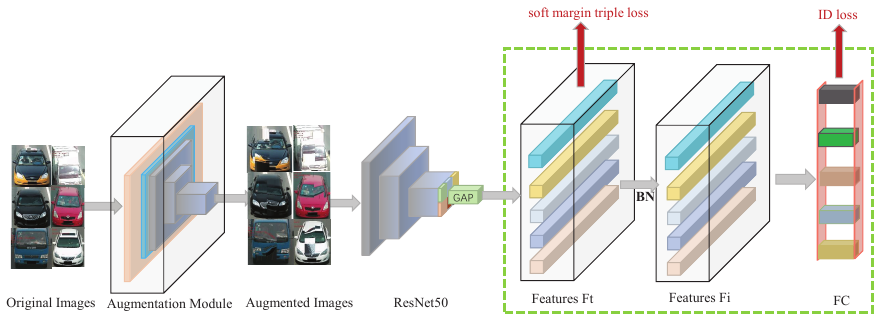
Figure 7. Framework of the Baseline.